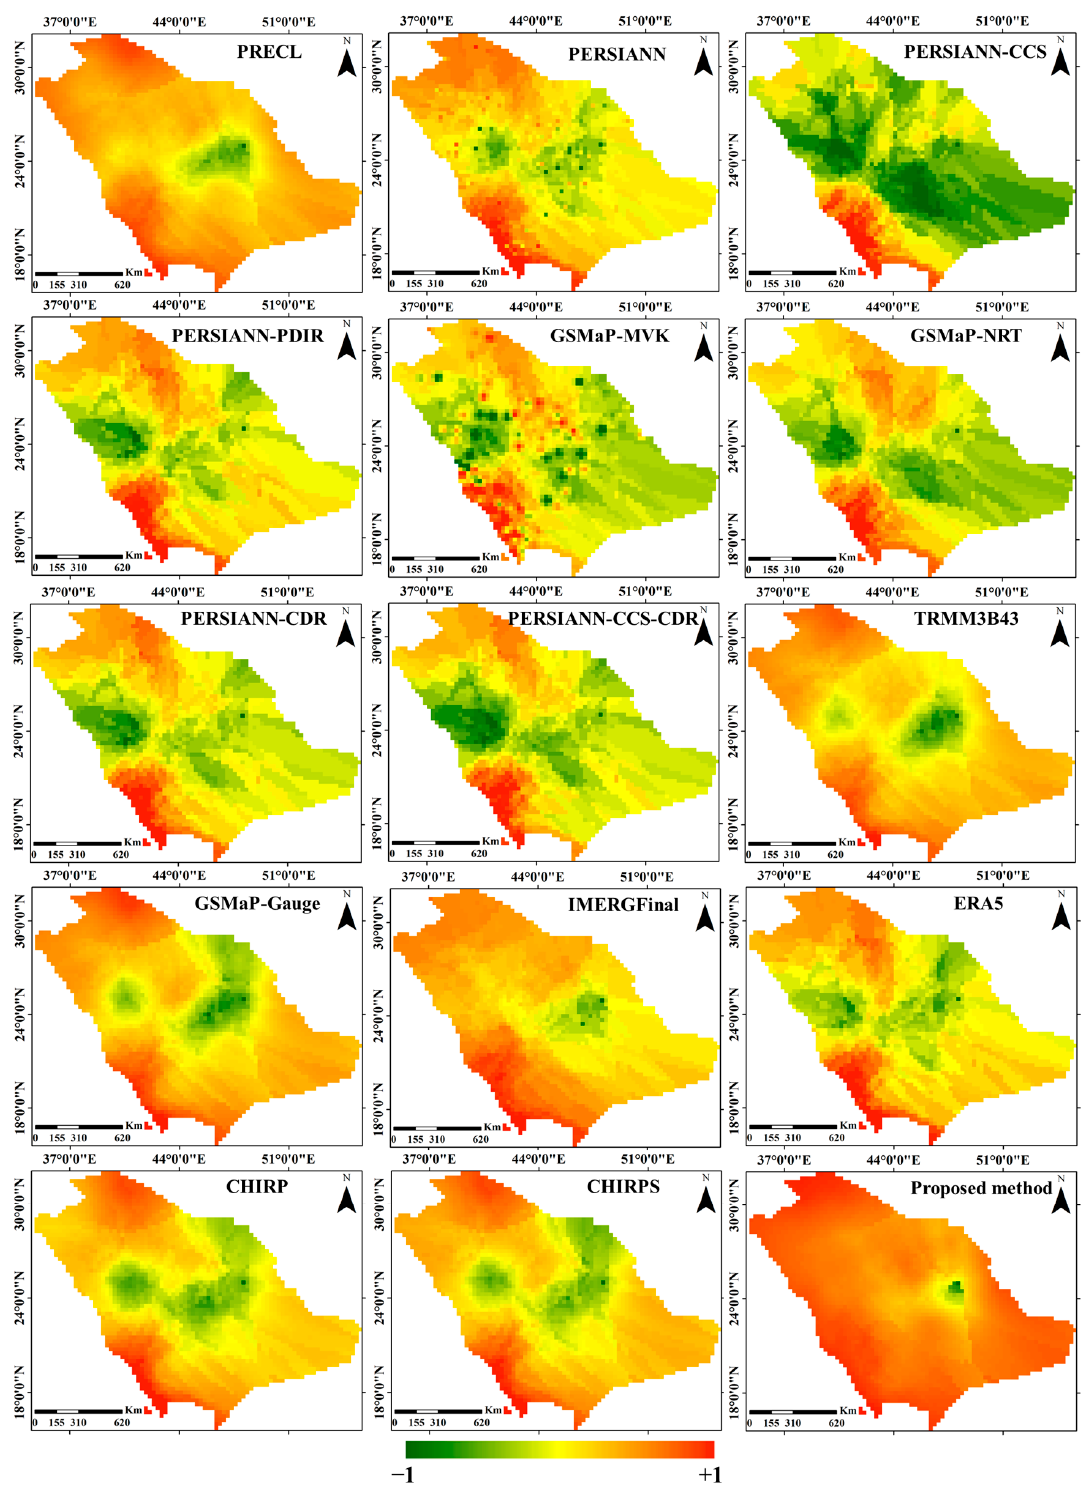
Figure 4. Spatial distribution of KGE for the precipitation datasets. The KGE values are computed at each pixel within 2003–2021 based on the precipitation map obtained from interpolation method.